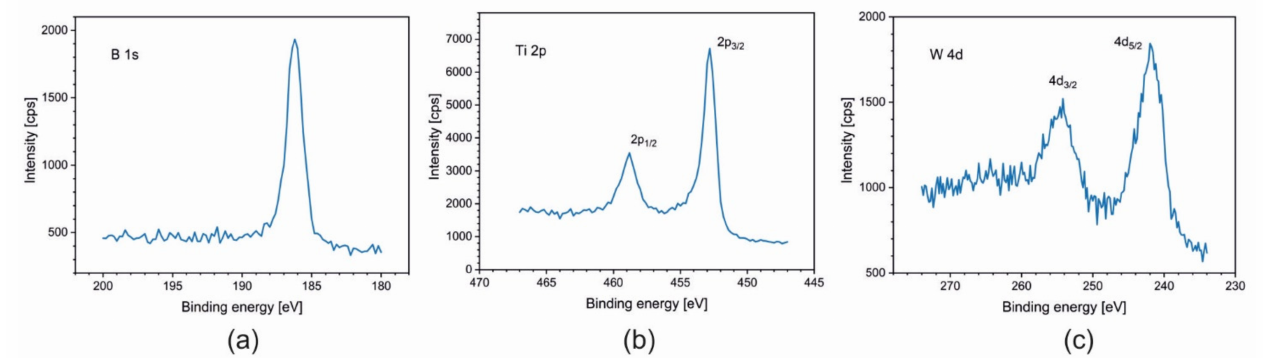
Figure 6. XPS spectra of ( a ) B 1s; ( b ) Ti 2p; and ( c ) W 4d obtained after 80 min of sputtering for the coating Ti 0.78 W 0.22 B 2